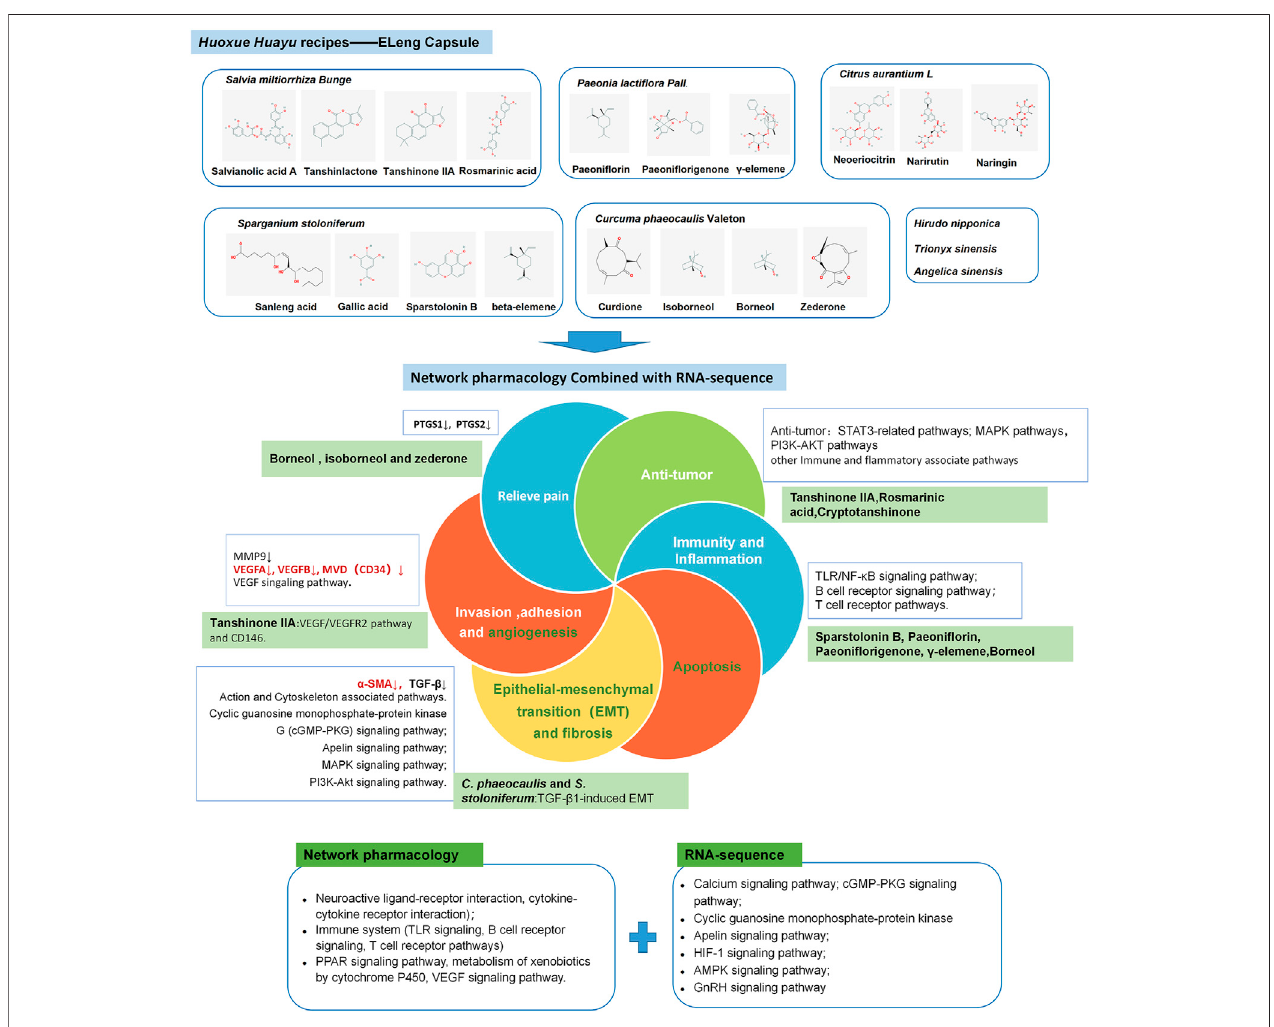
FIGURE 10 | Potential multiple target mechanisms of ELeng